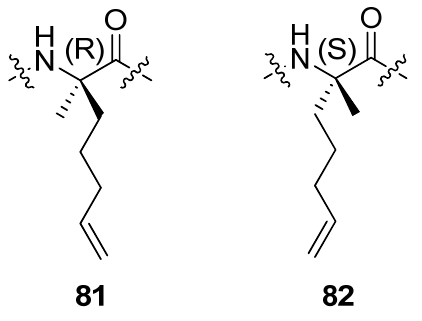
Figure 20. Incorporation of the amino acids 81 and/or 82 at positions i and i+4 in the C- peptide sequence of RNAse A followed by RCM does not result in macrocyclic peptides with enhanced